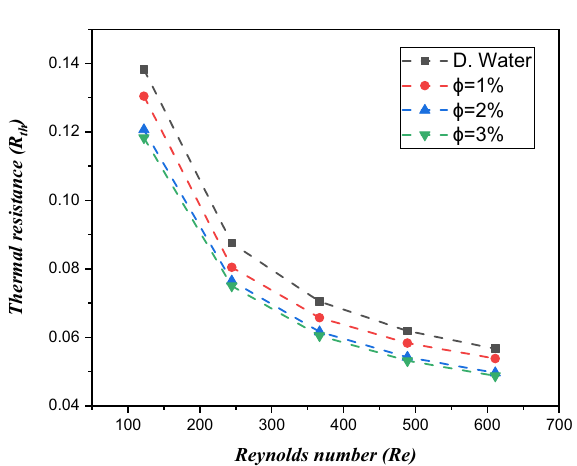
Figure 16. Estimation of the thermal resistance against the Reynolds number in a minichannel heat sink with TiO 2 /water nanofluid and distilled